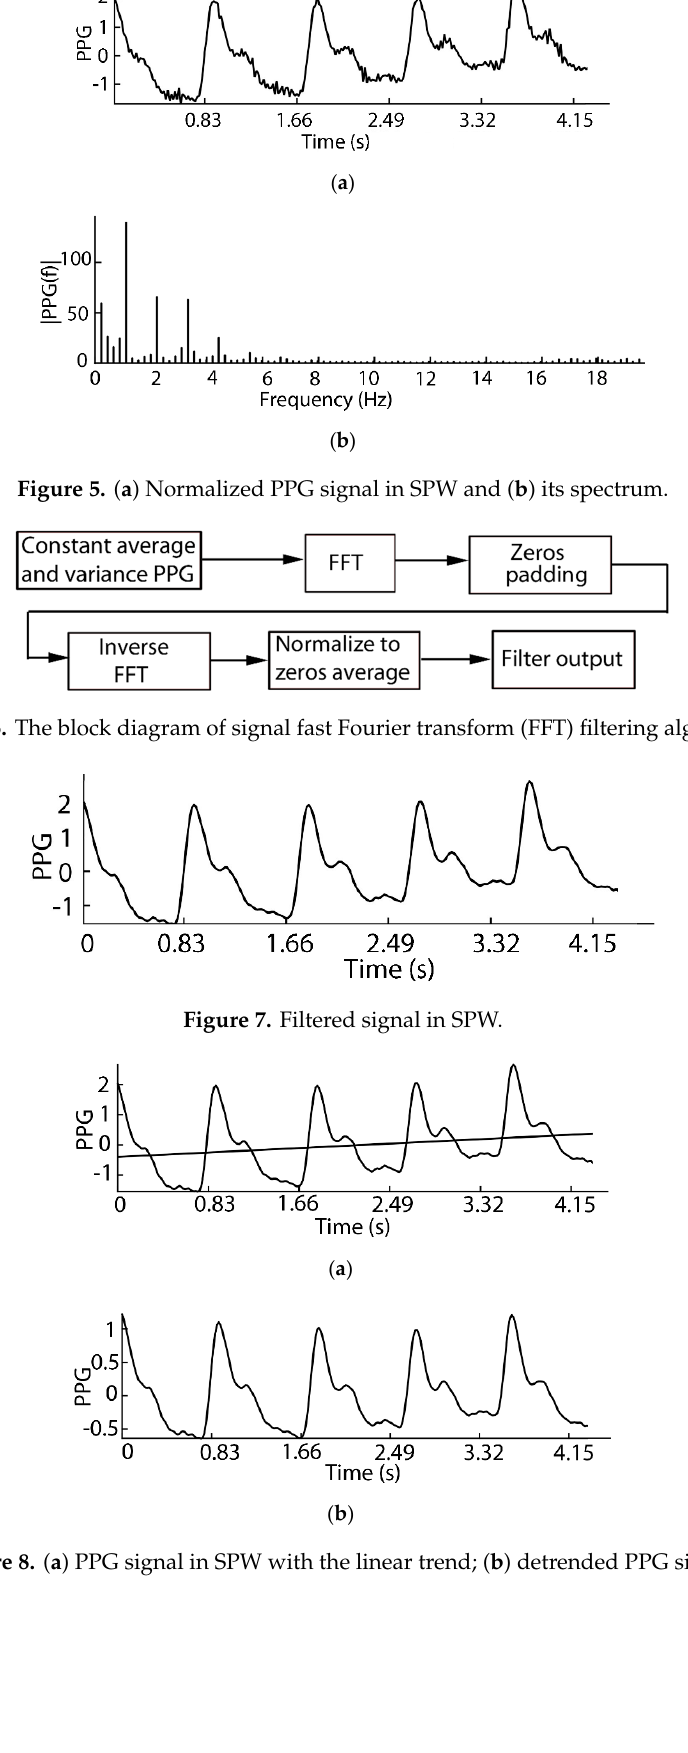
Figure 5. ( a ) Normalized PPG signal in SPW and ( b ) its spectrum.